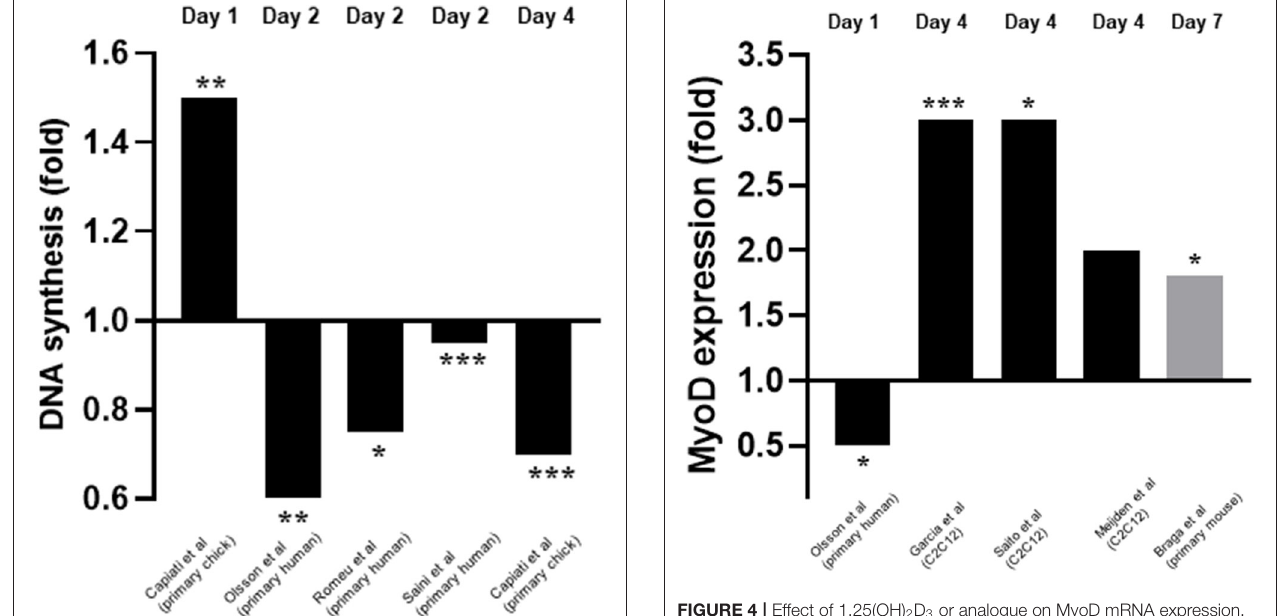
FIGURE 4 | Effect of 1,25(OH) 2 D 3 or analogue on MyoD mRNA expression. The active form of vitamin D [1,25(OH) 2 D 3 ] at 10 − 7 M was used in all studies apart from Saito et al. (2017) where Eldecalcitol (an analogue of the active form of vitamin D) was used. Black bars indicate mRNA expression whilst grey indicates protein expression. * p < 0.05, *** p < 0.001.